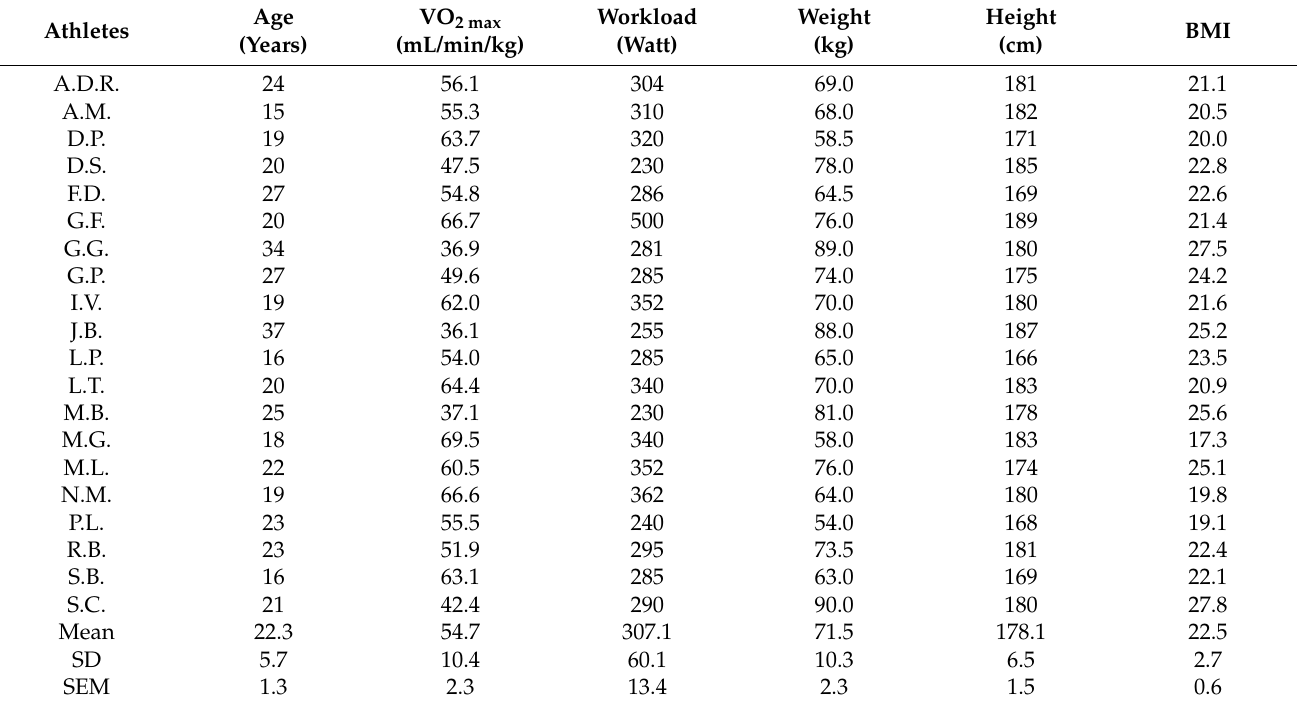
Table 1. Features of each participant of the